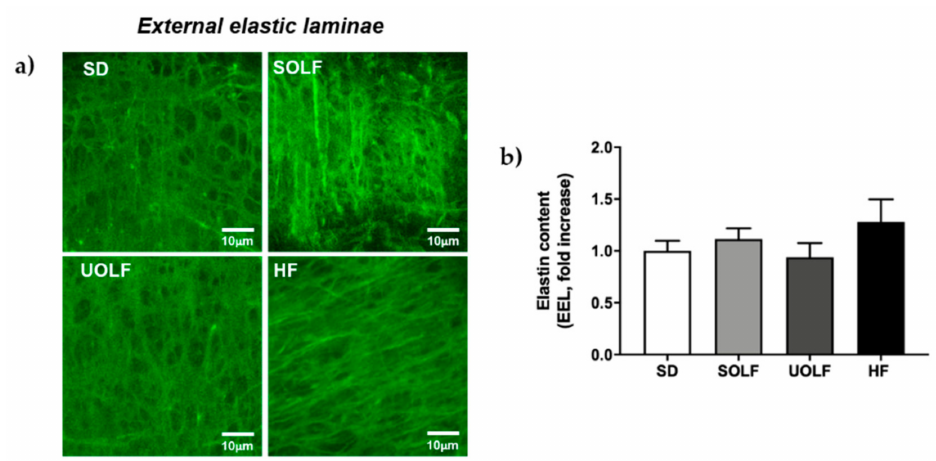
Figure 5. Elastin content and organization of external elastic laminae (EEL) in first-order MRA ( a ) Representative confocal microscopy images of projections of MRA’s EEL from SD, UOLF, SOLF, and HF mice. Projections were obtained from serial optical sections captured with a fluorescence confocal microscope (x63 oil immersion objective, zoom 2). ( b ) Bar graphs show fluorescence intensity, indicative of elastin content in EEL from SD, UOLF, SOLF, and HF animals. Results are expressed as mean ± SEM of n = 4–10.